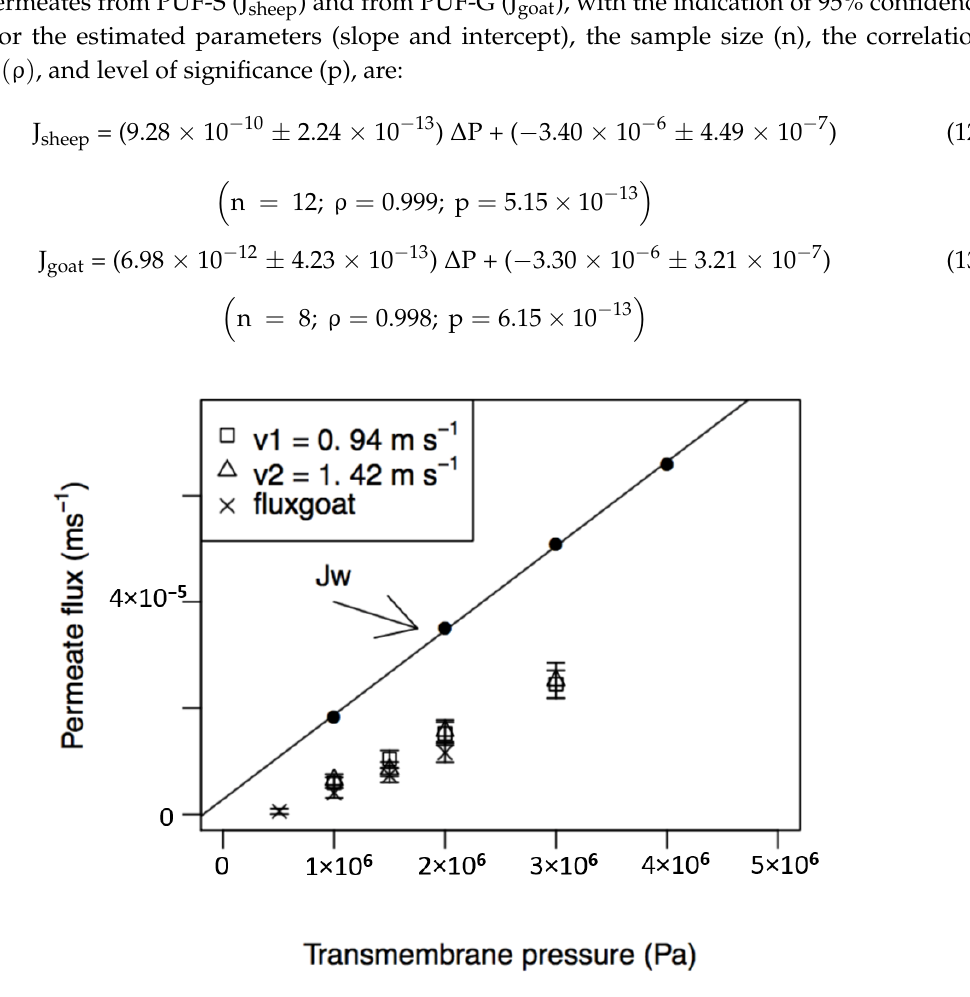
Figure 3. Influence of transmembrane pressure and feed circulation velocities on permeate fluxes, at a temperature of 25 °C, for PUF-S (at v 1 = 0.94 m·s −1 and v 2 = 1.42 m·s −1 ) and PUF-G (at v 1 = 0.94 m·s −1 ).